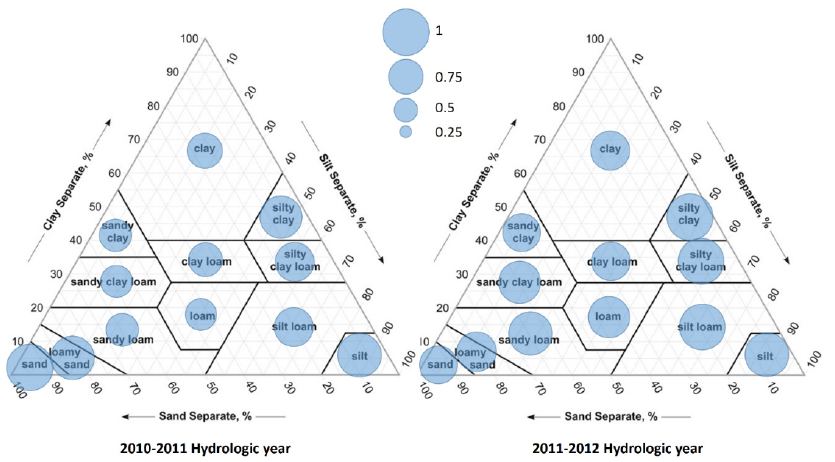
Figure 5. Days with ice, 2010–2011 and 2011–2012 hydrologic years. Results were normalized ranging from 0 to 1; each circle represents the scaled result. A bigger circle indicates the highest value in the metric.